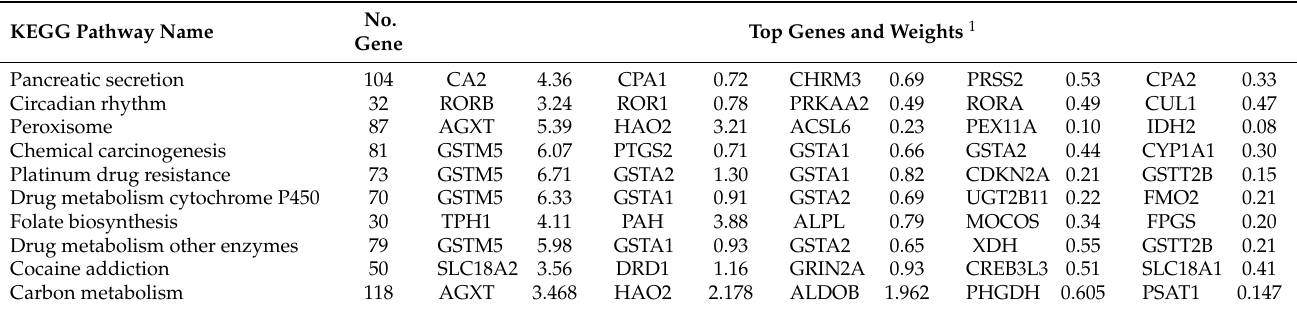
Table 3. Significant pathways and genes for